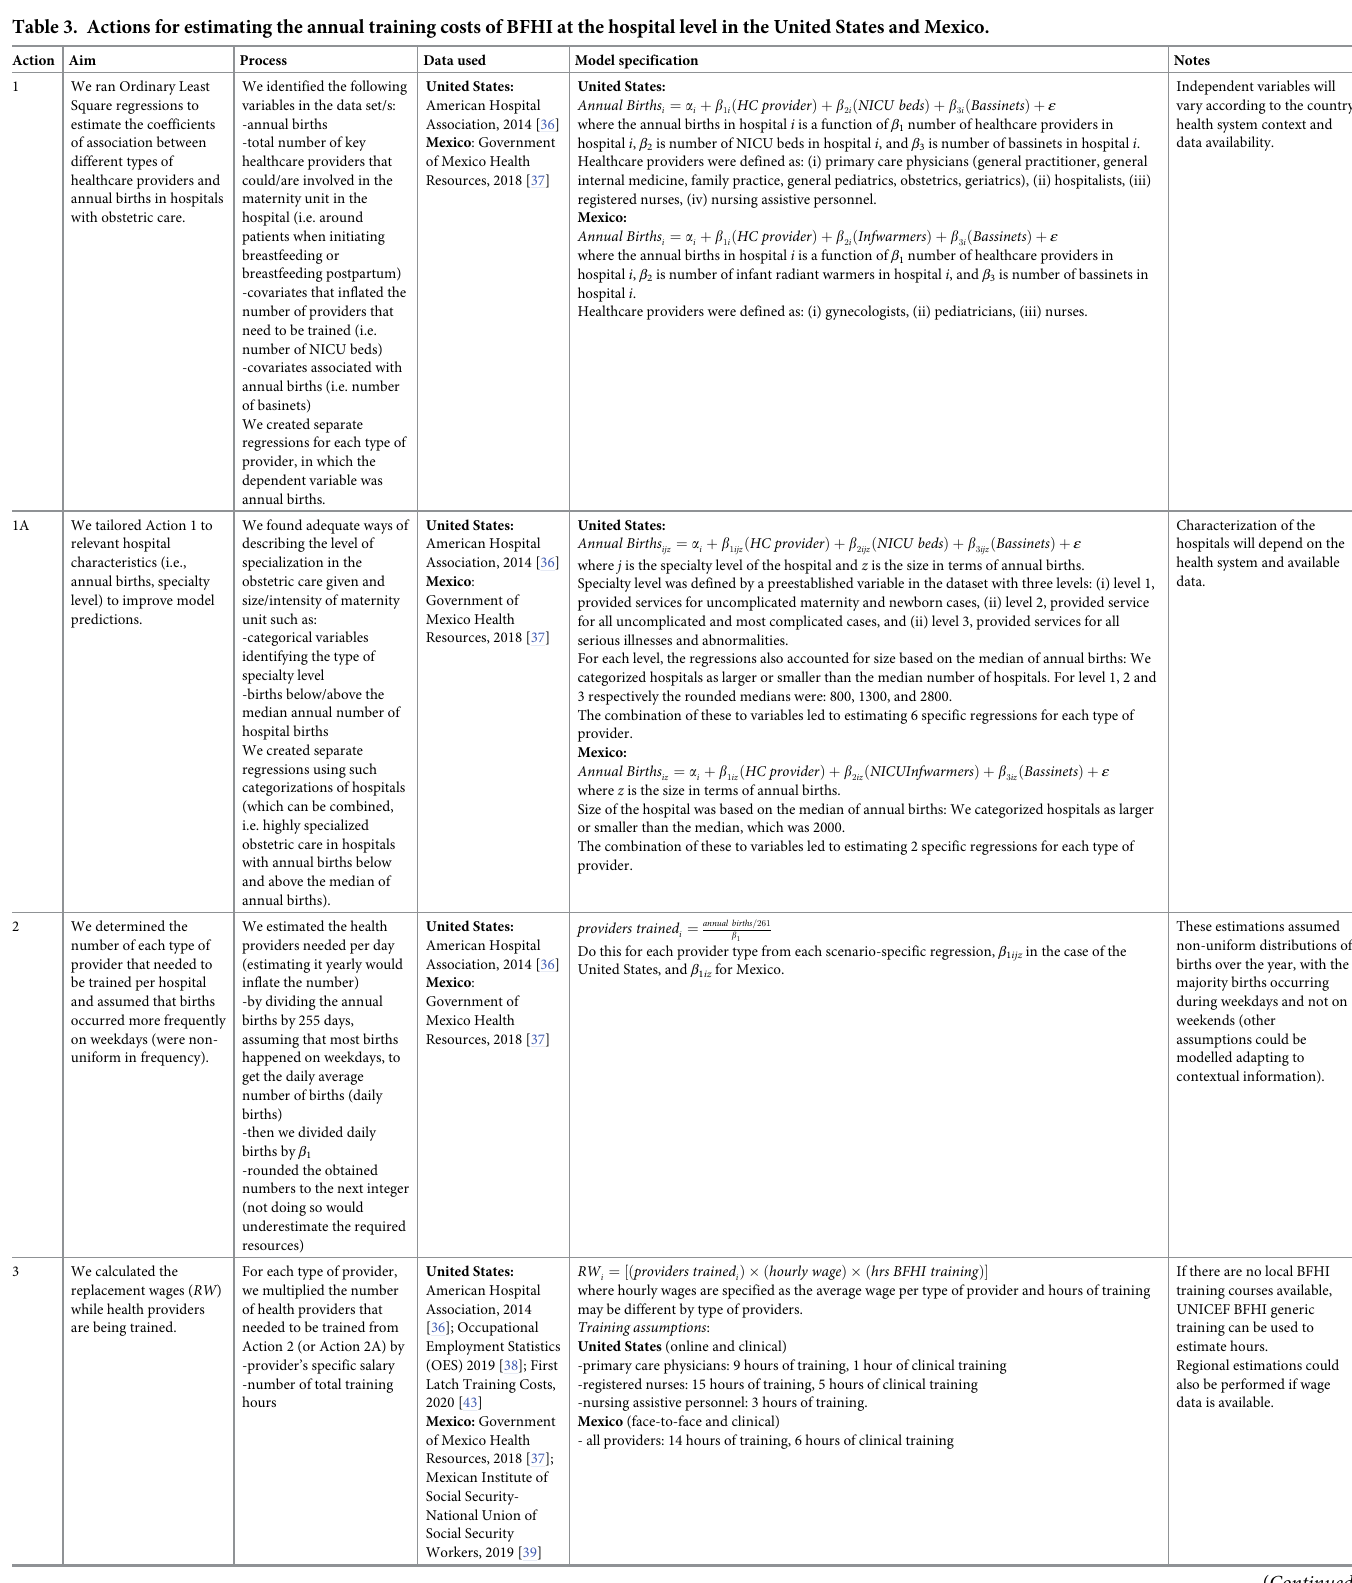
Table 3. Actions for estimating the annual training costs of BFHI at the hospital level in the United States and Mexico. Action